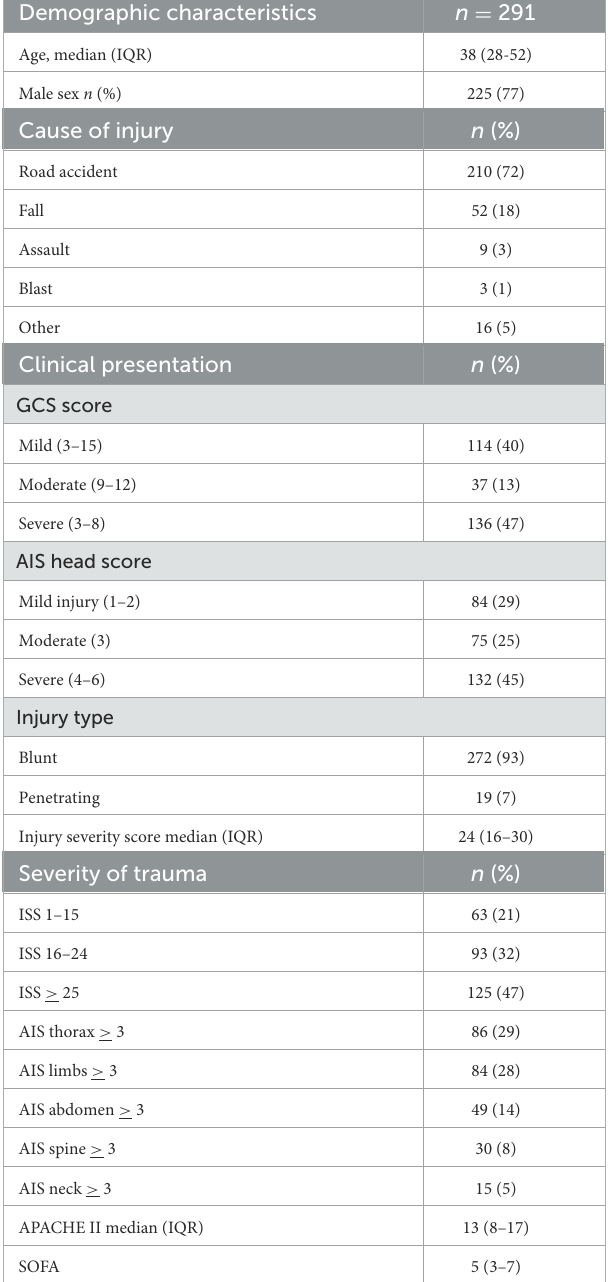
TABLE 1 Baseline and clinical characteristics of